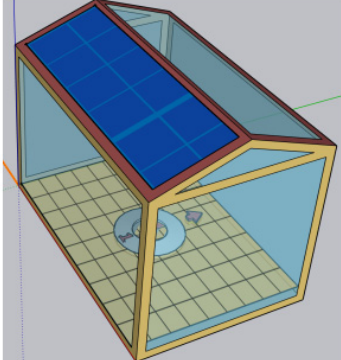
Figure 33. Solar array output power for 2 different decoupling capacitance values (zoomed in).